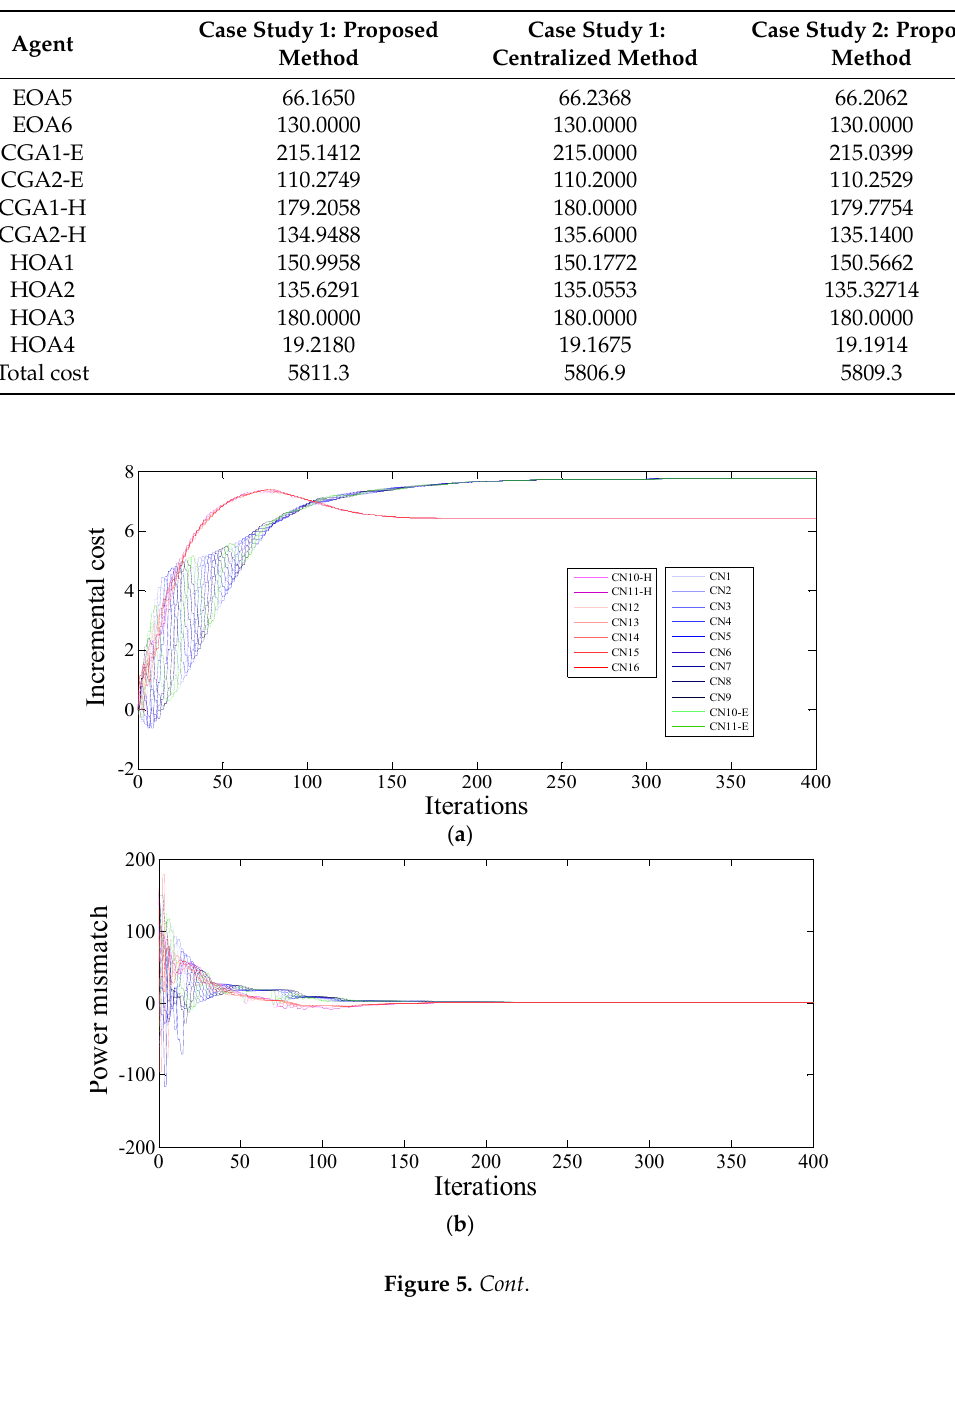
Table 2. Comparison for the 16-bus system.